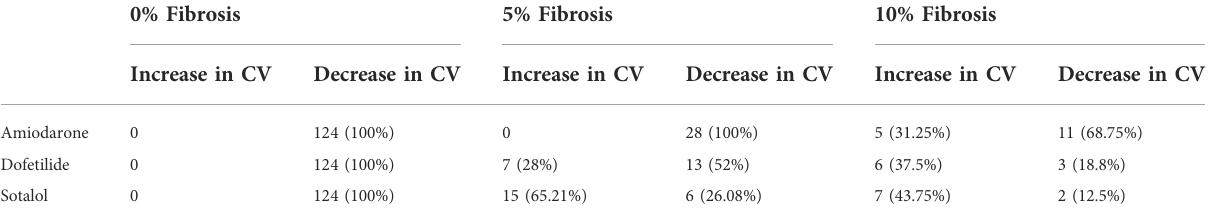
TABLE 2 Change in conduction velocity for the studied antiarrhythmic drugs under the effect of fi brosis (number of pro fi les and percentage). 0%